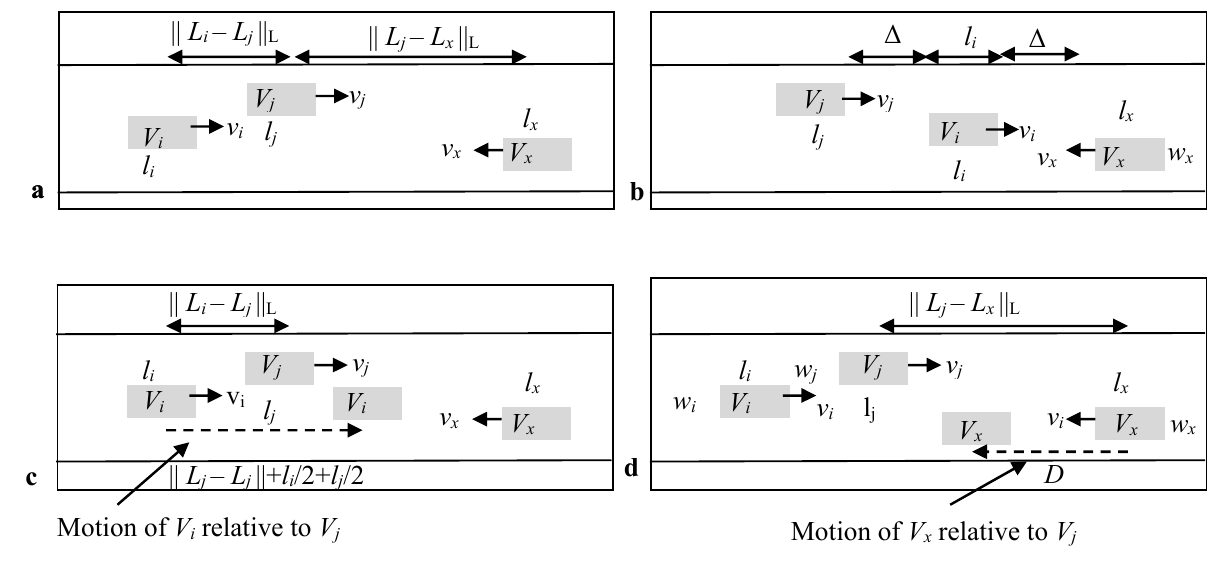
Figure 5. Notations for deciding feasibility of overtaking when three vehicles have enough longitudinal separation: ( a ) Initial Positions; ( b ) Final Positions; ( c ) Motion on V i relative to V j ; ( d ) Motion on V x relative to V j